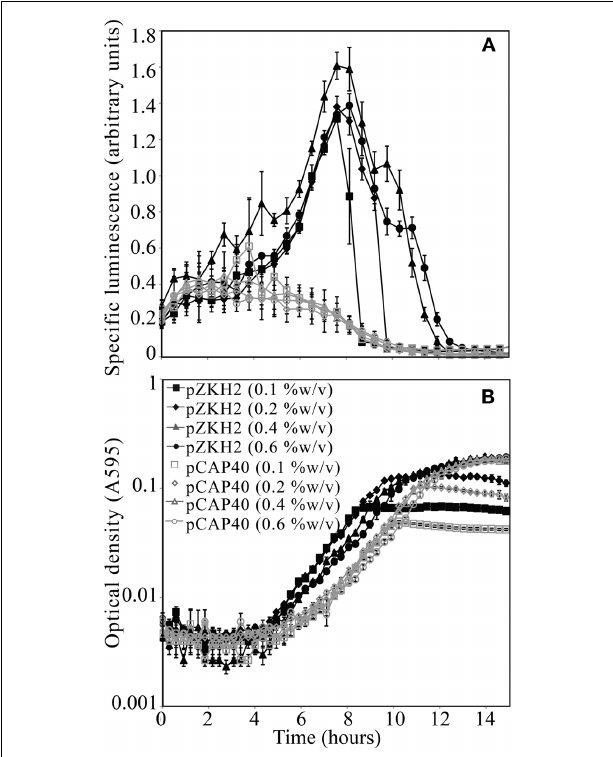
FIGURE 2 | (A) Specific luminescence ( × 10 5 ) from microbiosensor KT2440/pZKH2(black lines, filled symbols) and promoter-less KT2440/pCAP40 (gray lines, open symbols) throughout exponential growth and into stationary phase tracked using (B) optical density (A595). Bacteria were inoculated into M9 medium with four different concentrations (%w/v) of citrate in 48-well plates. All values are mean ±